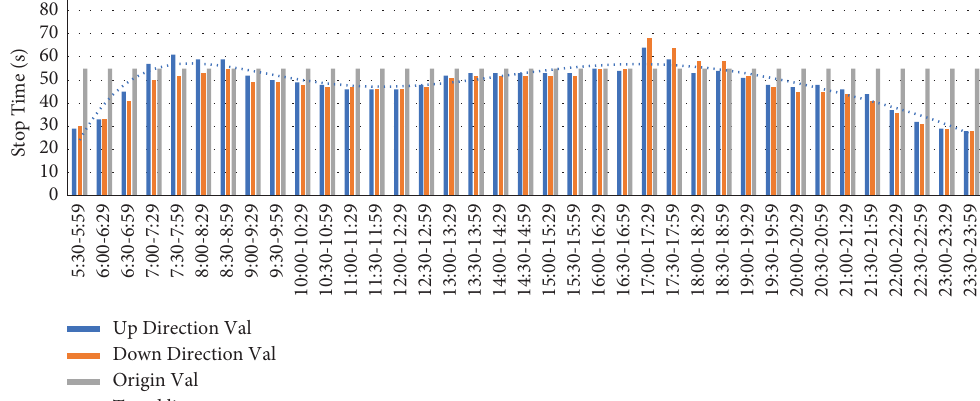
Figure 12: Te stop time at station